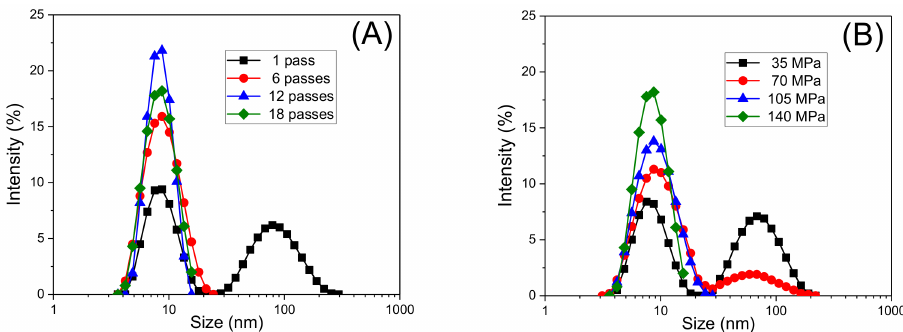
Figure 2. Droplet size distributions for emulsions aged for 24 h as a function of ( A ) the number of passes at a fixed homogenization pressure of 140 MPa and ( B ) homogenization pressure processed at a fixed number of passes of 18.